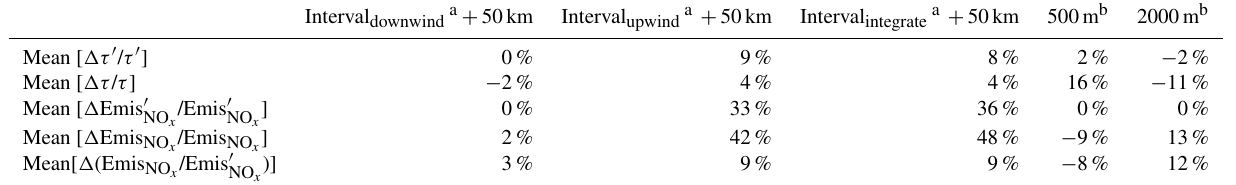
Figure 8. Scatterplots of (a) the fitted NO x lifetime τ as compared to the NU-WRF lifetime τ (cid:48) and (b) the fitted NO x emissions Emis NO as compared to the given emissions Emis (cid:48) . Error bars show the standard error of the fitted results for all available wind directions. NO x √ n , with n being the number of available wind directions. The results derived Standard error is defined as standard deviation divided by from MISATEAM, the approach of Beirle et al. (2011), and the approach of Liu et al. (2016b) are displayed by blue, grey, and red dots, respectively. The dashed line represents the 1 : 1 line. Note that (b) is plotted on a logarithmic scale. Table 1. The mean relative change of lifetimes and emissions for different choices of fit and integration intervals and wind fields. Interval downwind a + 50km Interval upwind a + 50km Interval integrate a + 50km 500m b 2000m b Mean [ (cid:49)τ (cid:48) / τ (cid:48)